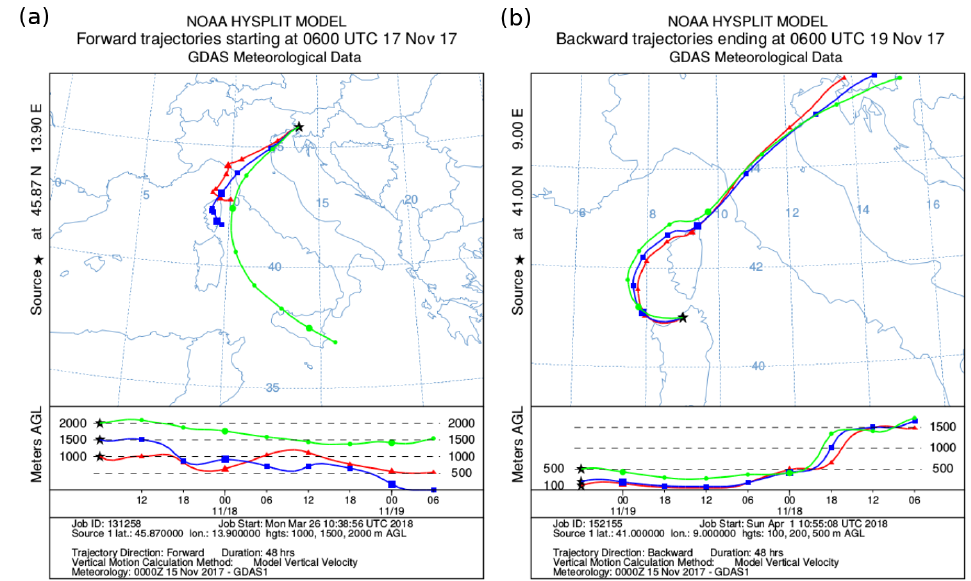
Figure 9. Air-mass flow trajectories for a period of 48 h, obtained by the HYSPLIT model. ( a ) Forward trajectories originating over Vipava valley at 07:00 CET (UTC + 1) on 17 November 2017 at the altitudes of 1000m, 1500m and 2000m (blue, red and green); ( b ) backward trajectories arriving over Corsica at 07:00 CET (UTC + 1) on 19 November 2017 at the altitudes of 100m, 300m and 500m (blue, red and green), the trajectories were mainly from above the Viapva